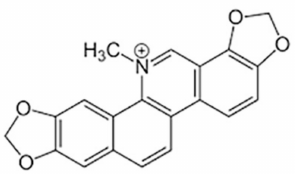
Figure 1. Chemical structure of